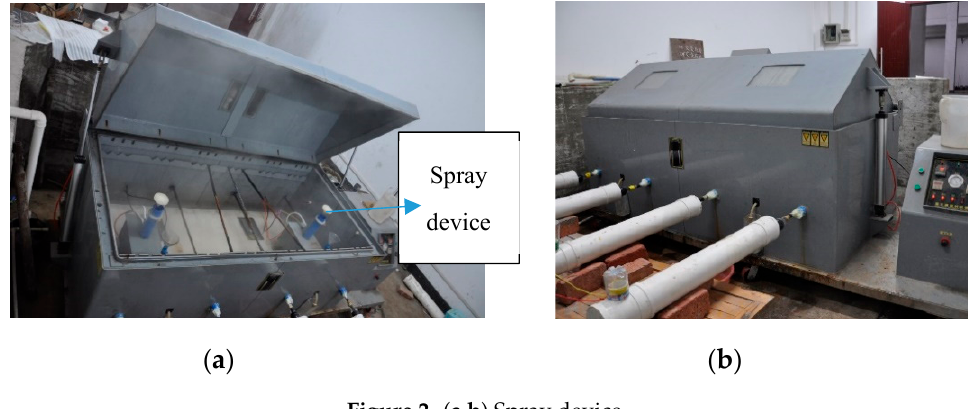
Figure 2. ( a,b ) Spray device. Table 2. Chemical composition of the salt solution.